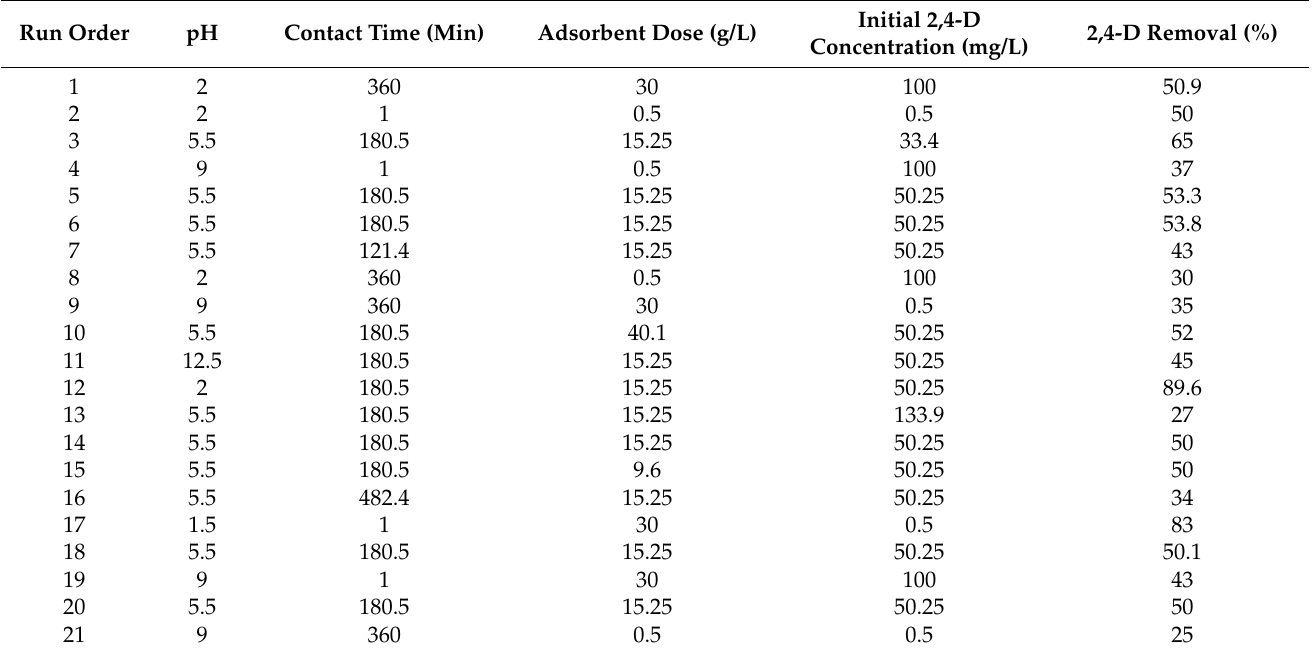
Table 6. 2,4-D experimental design matrix adsorption percentage values.